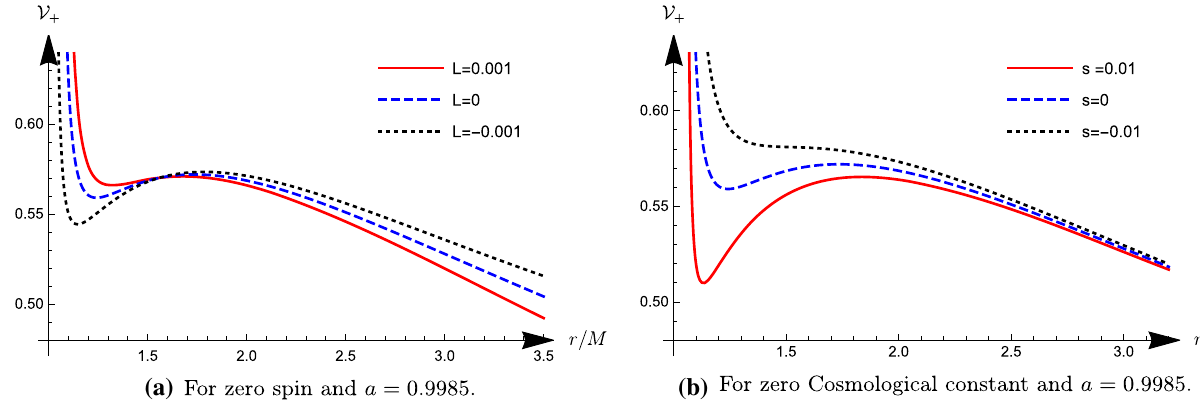
Fig. 1 The dependence of velocity V on the radial position of a spin- ning particle. As one can see, for the negative cosmological constant the minimum value of angular velocity is smaller than zero one. It is